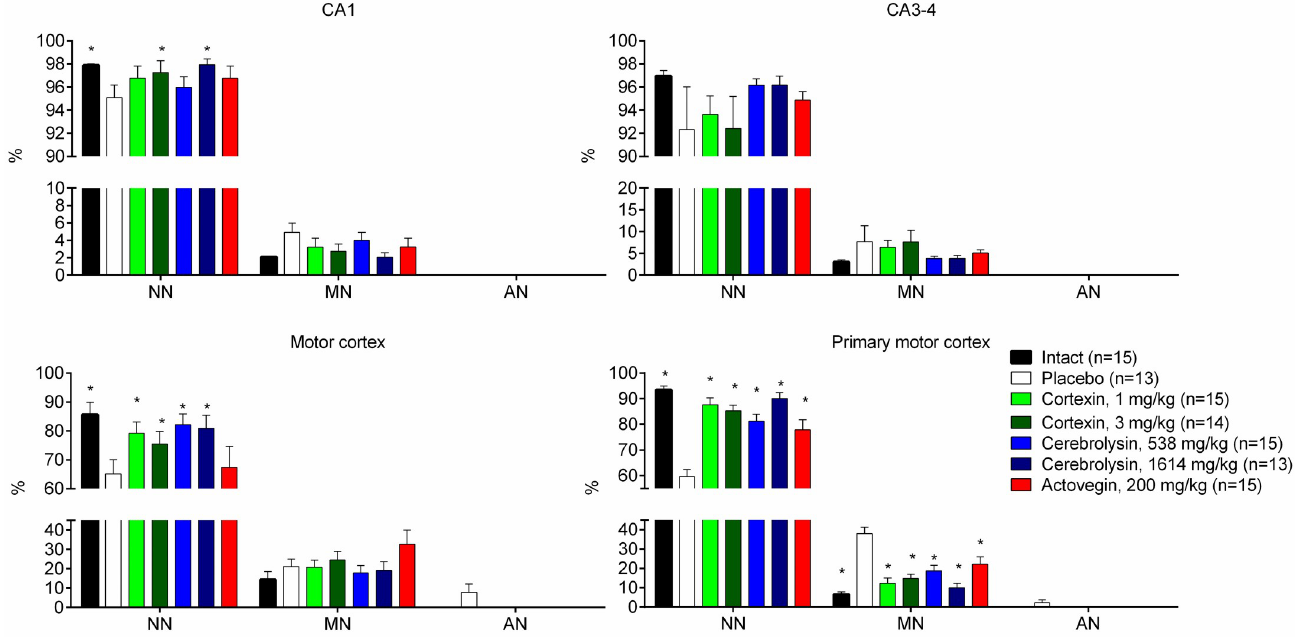
Fig 12. Hippocampal morphology in animals with chronic brain ischemia. NN–normal or unchanged neurons; MN–slightly modified neurons; AN–roughly altered neurons; #–p < 0.05 compared to Intact; � –p < 0.05 compared to placebo (Kruskal-Wallis rank analysis and the Dunn post-hoc test); data shown as the mean ±